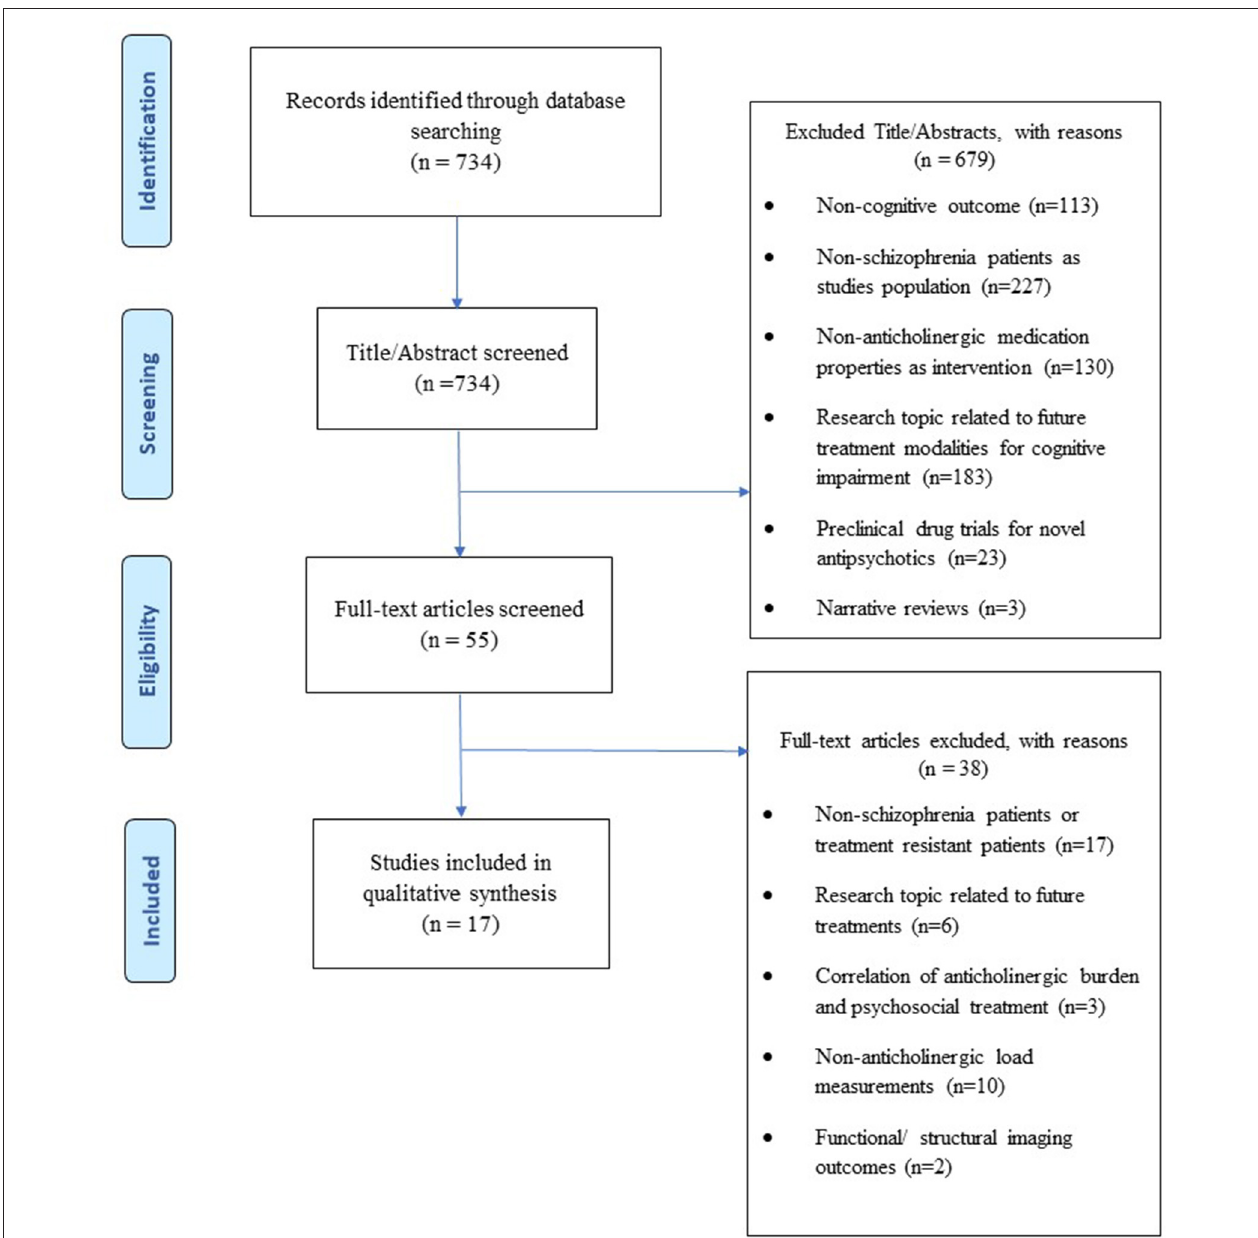
FIGURE 1 | PRISMA flow diagram of search strategy and final selection of articles.